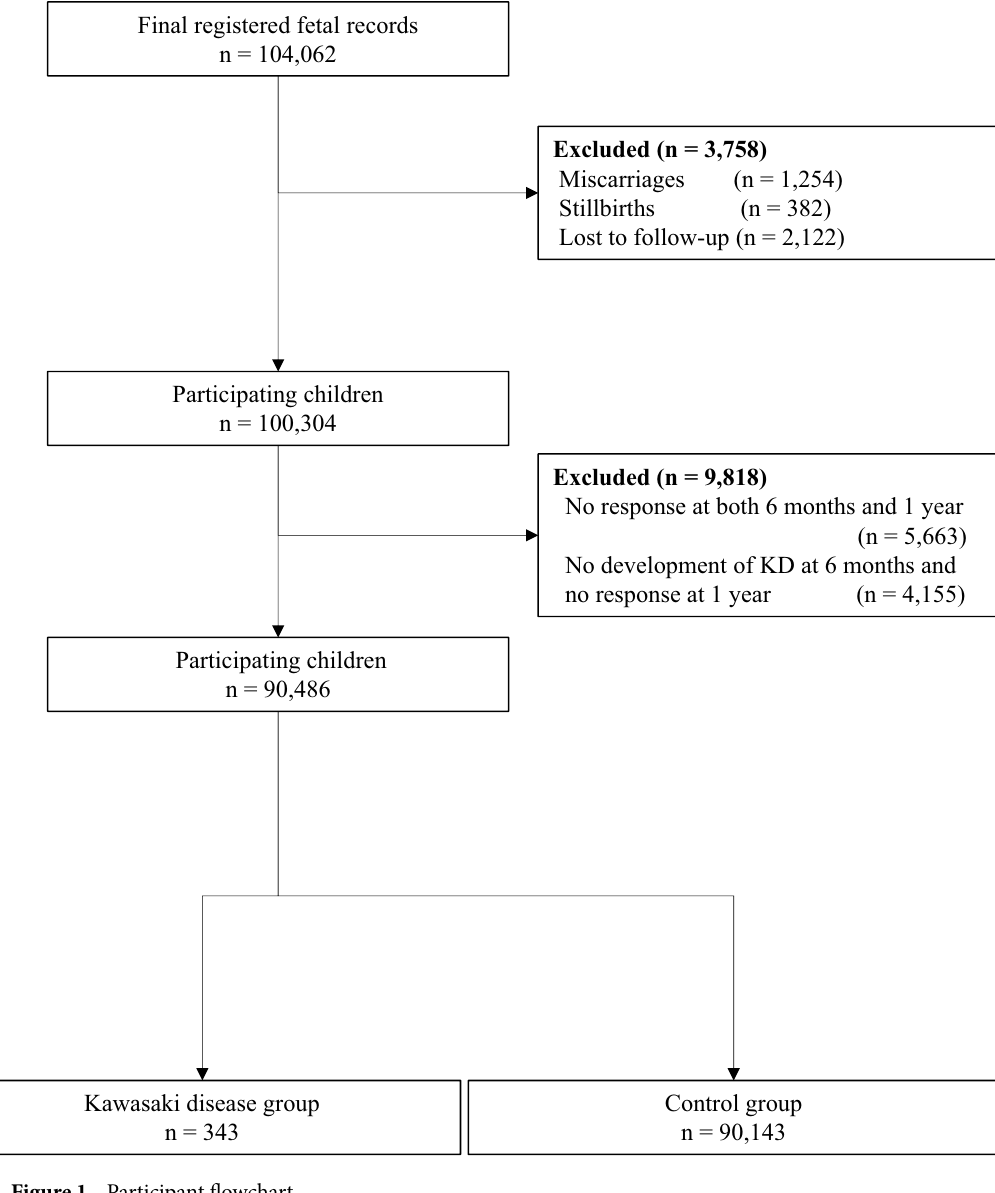
Figure 1. Participant